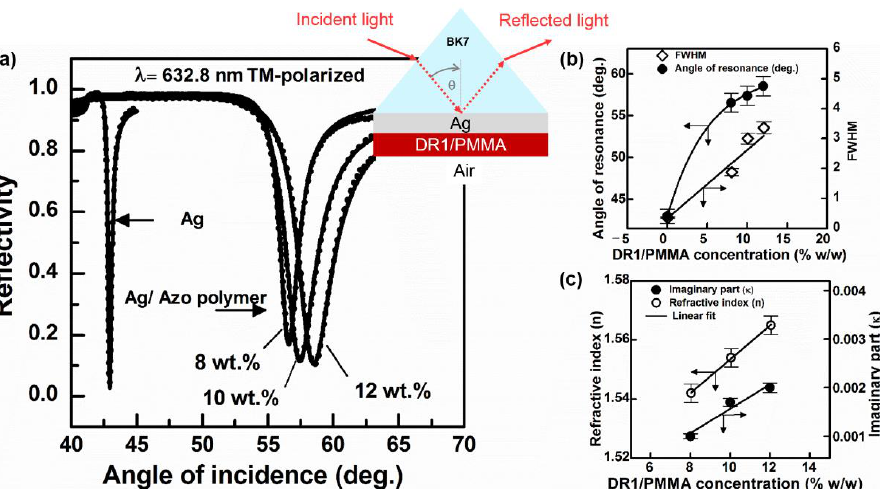
Figure 3. Angle-scan ATR spectra in a Kretschmann configuration for a single Ag layer (56 nm) at a wavelength of 632.8 nm. ( a ) Experimental (dots) and theoretical (solid curve) ATR spectra of an Ag layer sample without and with DR1/PMMA thin films ( d ~ 58 nm) at 8%, 10%, and 12% w / w as indicated on the figure. ( b ) Dependence of SPR angle and full width at half maximum (FWHM) versus DR1 concentration in PMMA. ( c ) Refractive index (real, 𝑛 , and imaginary, 𝜅 , parts) of DR1/PMMA versus DR1 concentration. Note the linear dependence of 𝑛 and 𝜅 of DR1/PMMA on the DR1 concentration. The scatters are experimental data adapted from the SPR curves at the corresponding concentrations, and the full lines are guides to the eye.